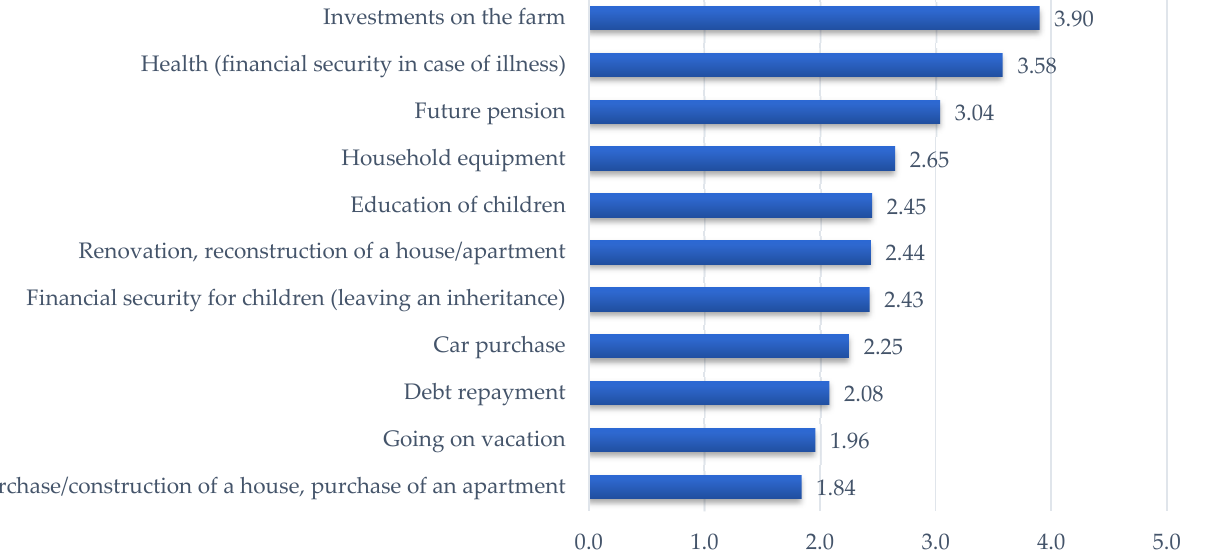
Figure 3. Goals for collecting savings by the surveyed agricultural households ( n = 191). Note: assessment using a five-point Likert scale; 1—unimportant goal, 5—most important goal. Source: own study.